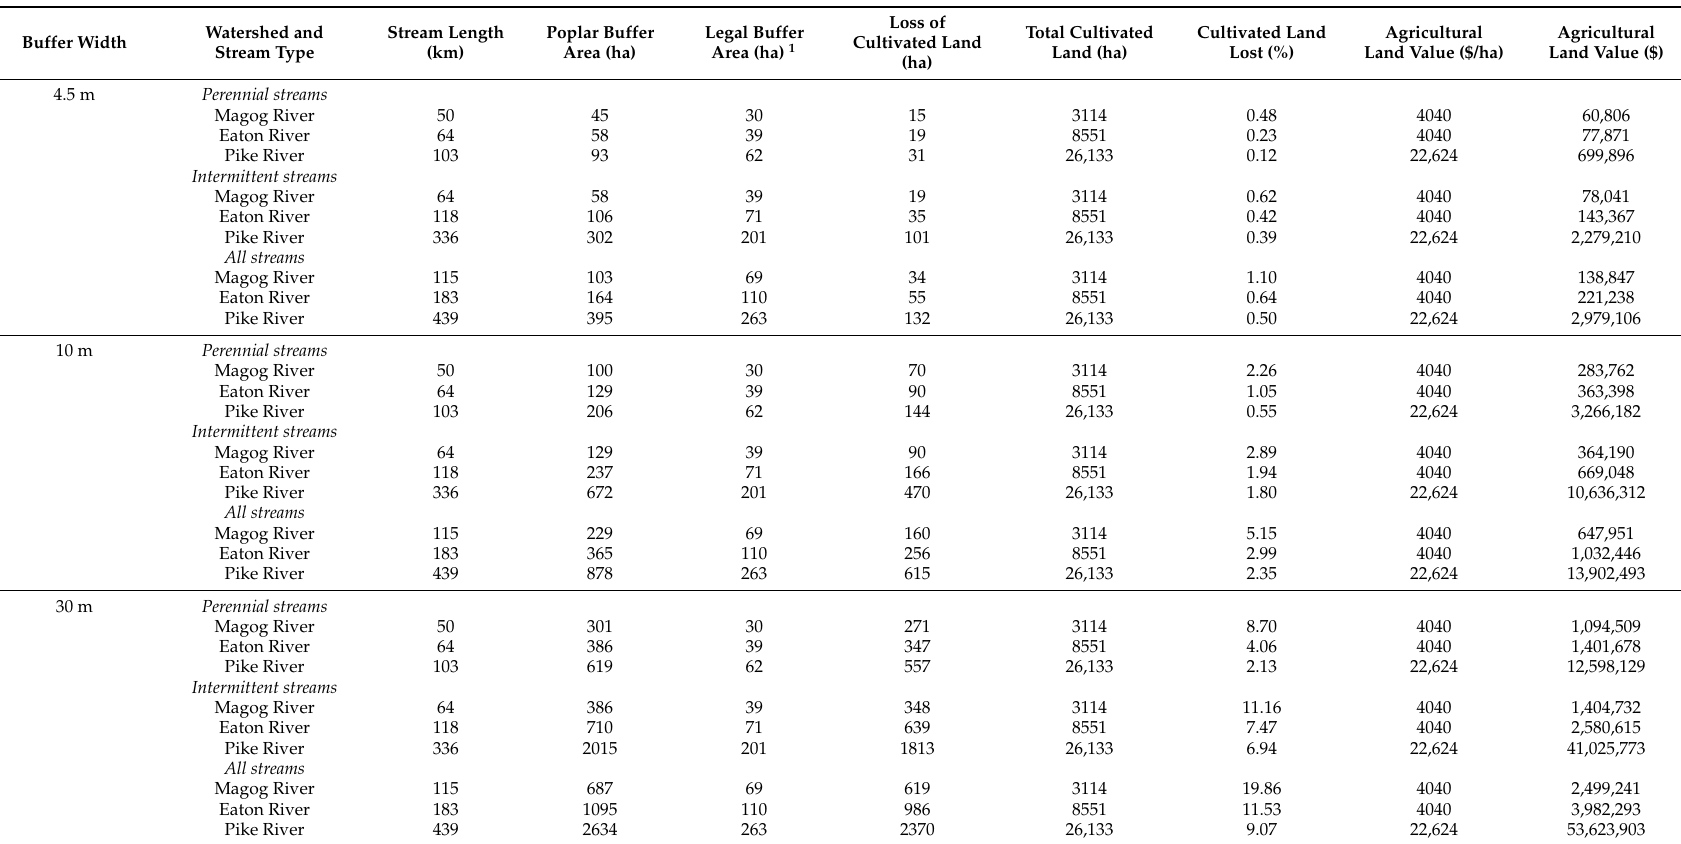
Table 8. Potential loss of cultivated land following the implementation of hybrid poplar buffers of various width along all non-forested perennial and intermittent farm streams in the three studied watersheds. The value of the cultivated land that would be lost is also indicated (in Canadian $).